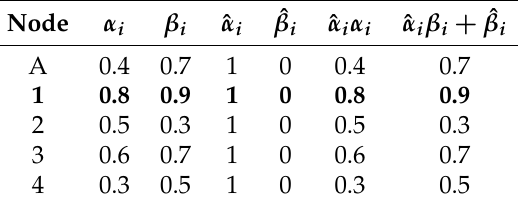
Table 2. The initial clock